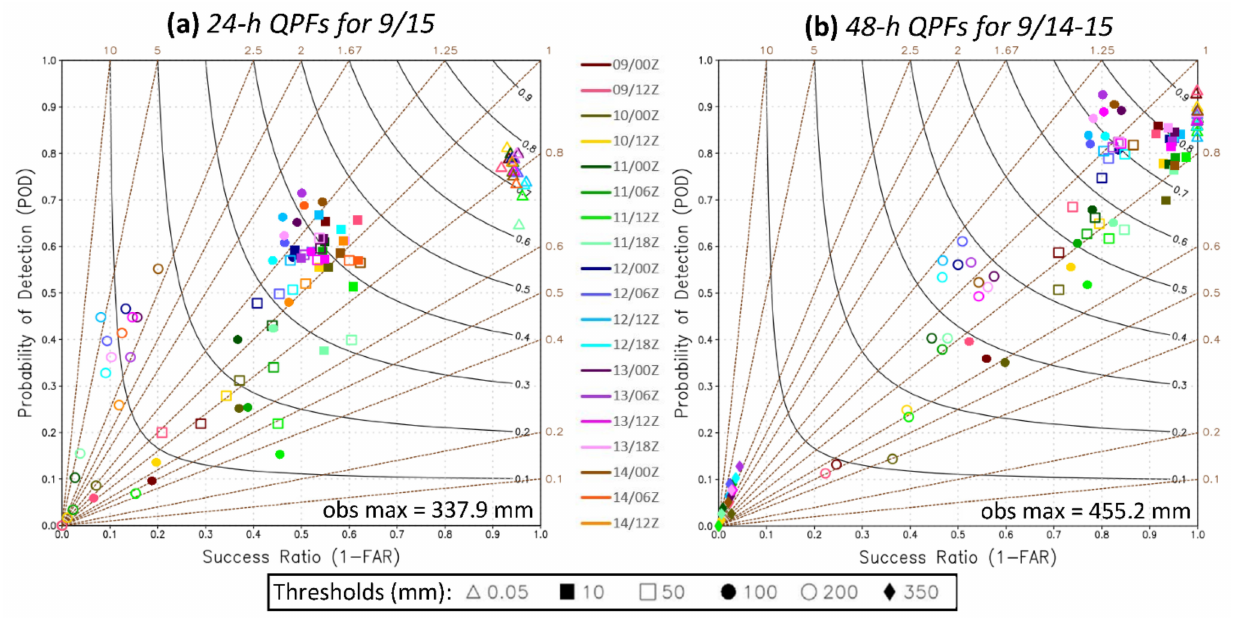
Figure 7. Performance diagrams for ( a ) 24 h QPFs targeted for 15 September and ( b ) 48 h QPFs targeted for 14–15 September (all in UTC) created with forecasts at different initial times (color) during TY Mangkhut (2018), verified against the GPM IMERG rainfall data at six selected thresholds from 0.05 to 350 mm (symbol, see inset at